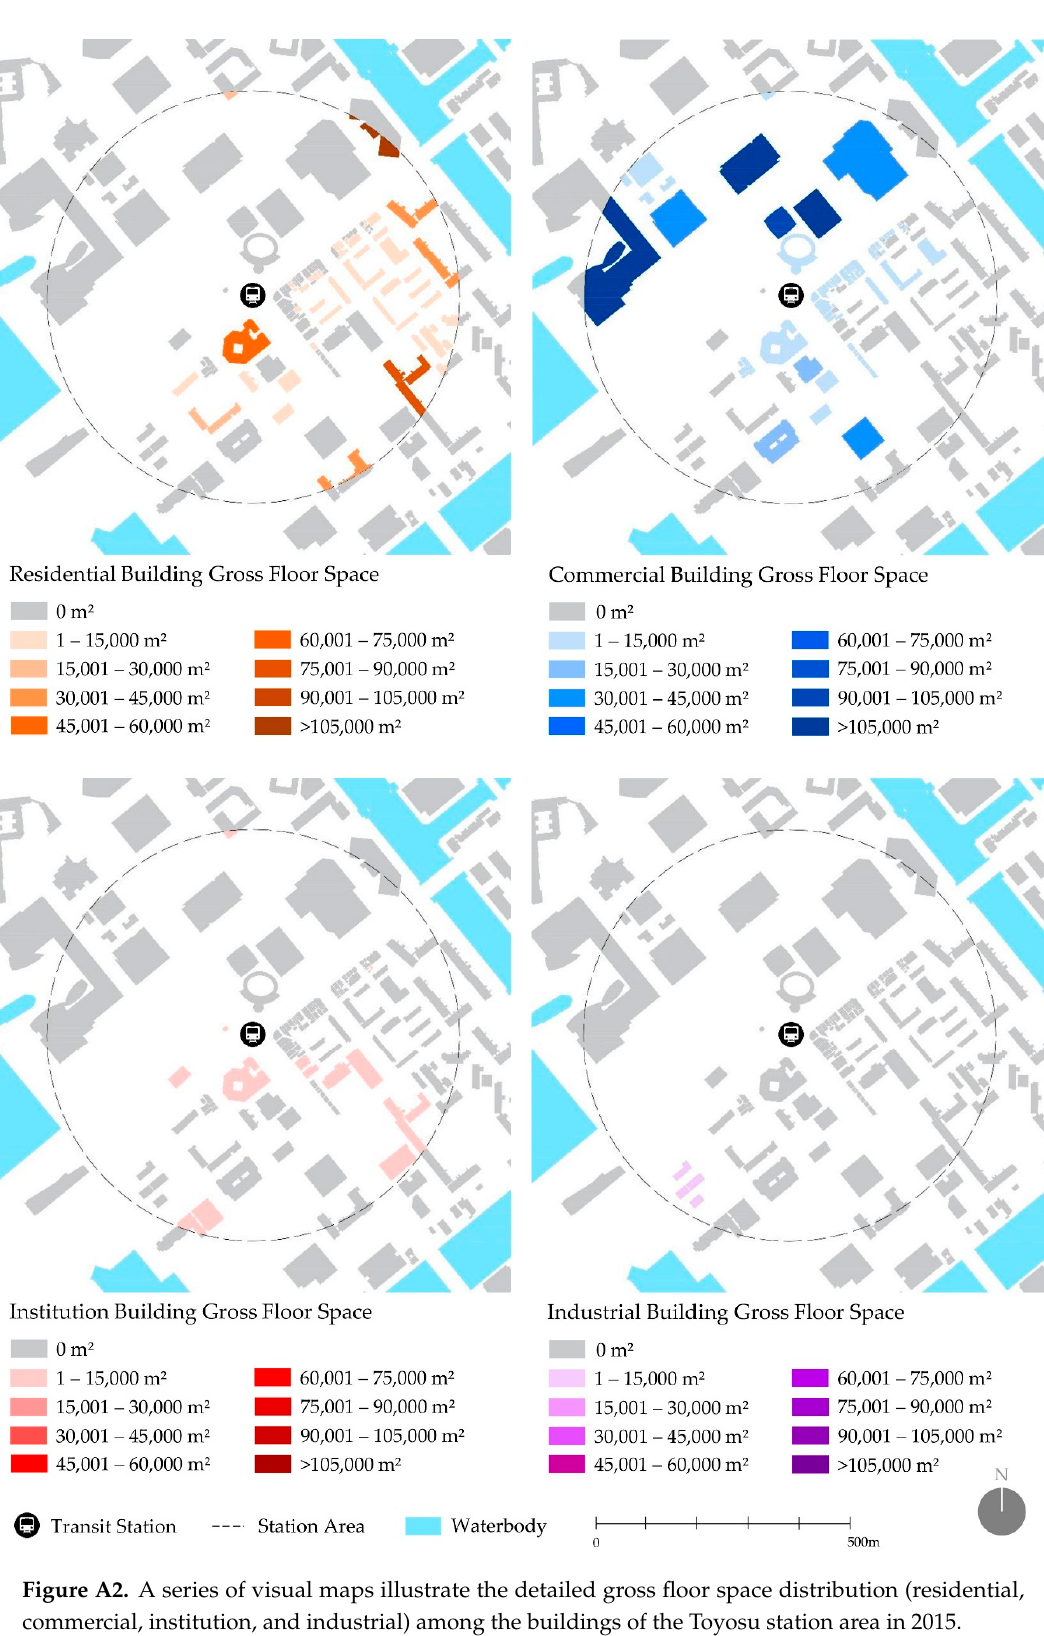
Figure A2. A series of visual maps illustrate the detailed gross floor space distribution (residential, commercial, institution, and industrial) among the buildings of the Toyosu station area in 2015.